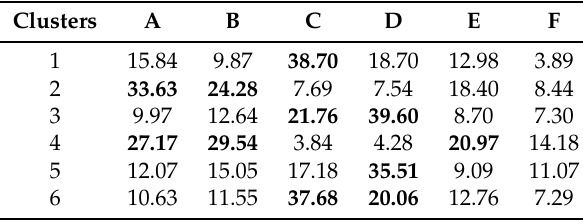
Table 3. Table of Contingency between non-normalized clusters (from 1 to 6) and normalized clusters (from A to